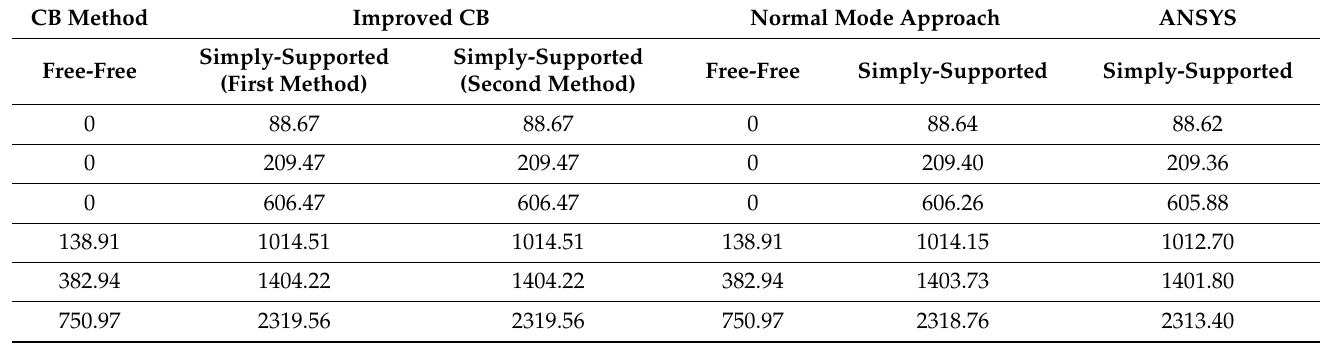
Table 4. Comparative analysis of the frequencies from different methods (Hz).